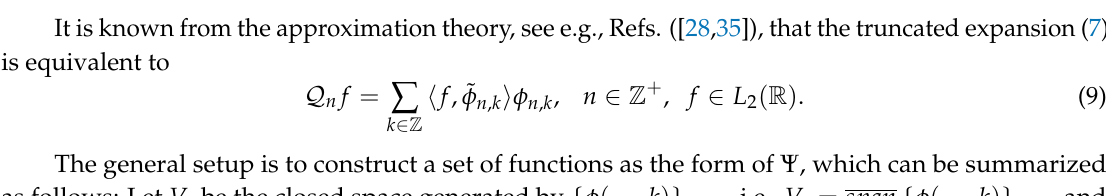
Figure 1. The graphs of the kernel, D 2 ( x , y ) , using the framelets of Example 2, 3 and 4,